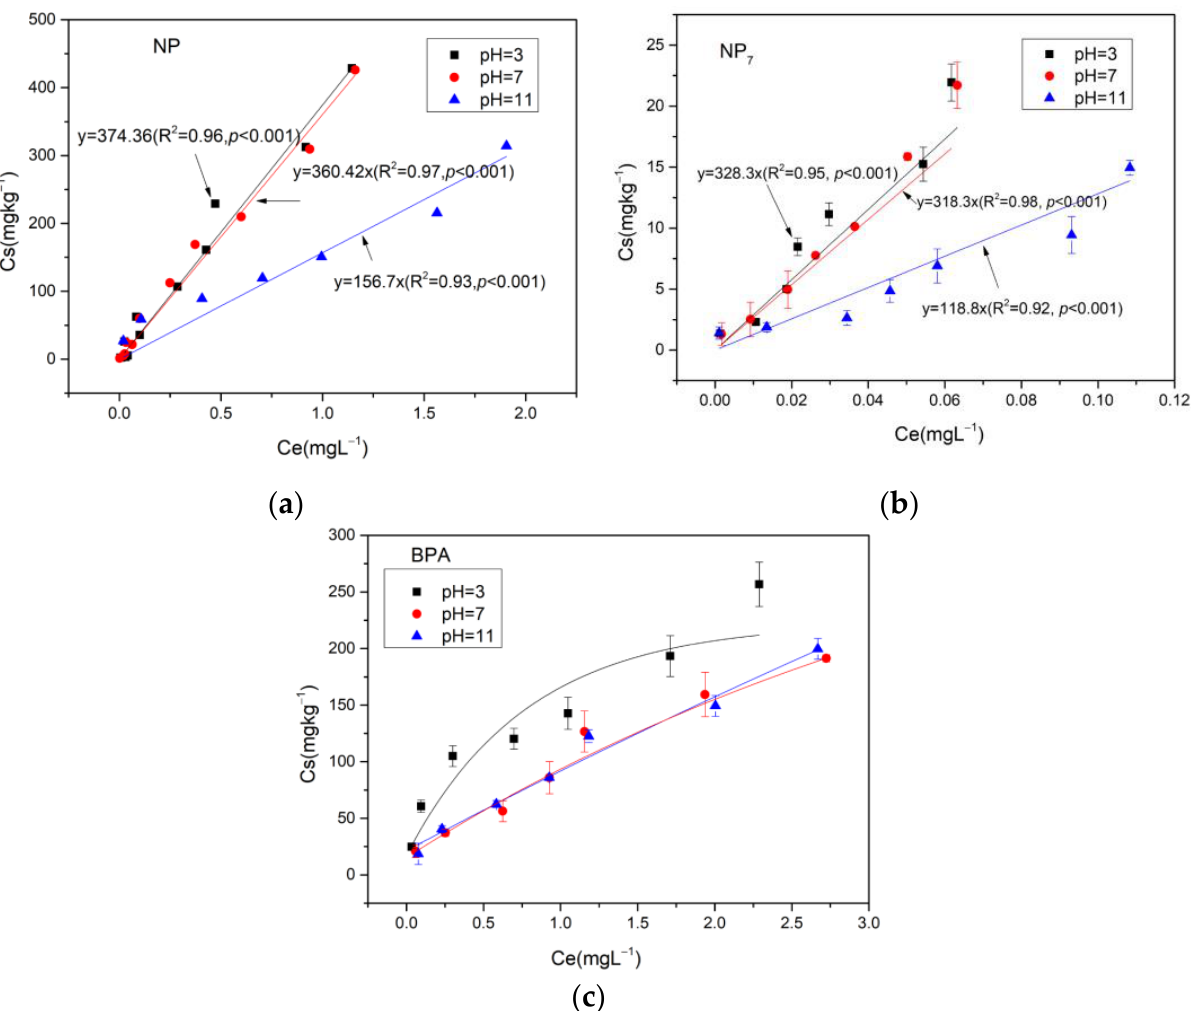
Figure 2. Adsorption of ( a ) NP, ( b ) NP 7 and ( c ) BPA on soil at different pHs.